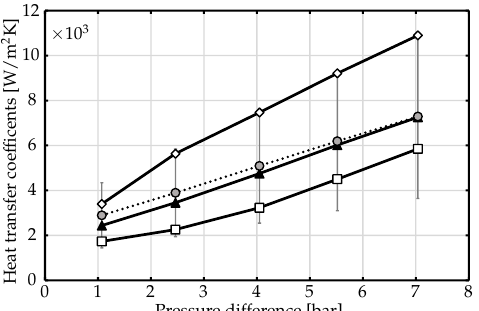
Figure 2. Heat transfer coefficients at the bristles α b ; Gnielinski [35] ( ), Žukauskas [36] ( ), Mart in [37] ( ), Average values ( ).